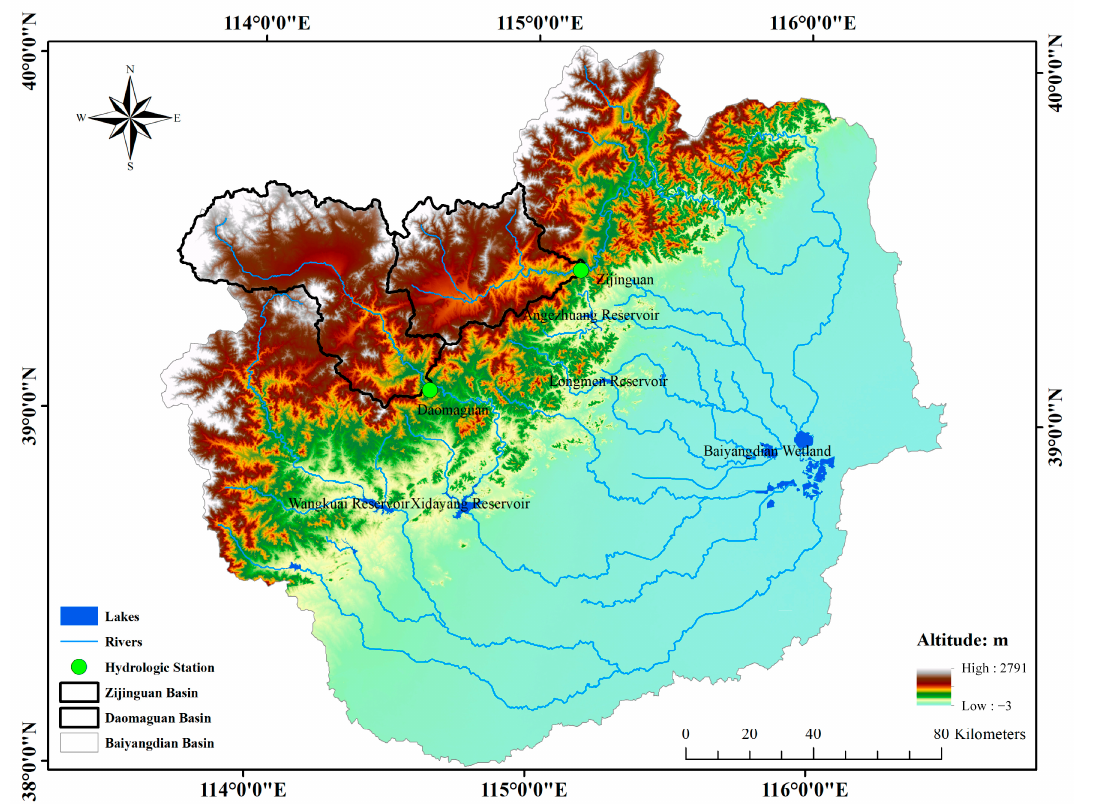
Figure 1. Location of the river basins and gauge stations in this study.